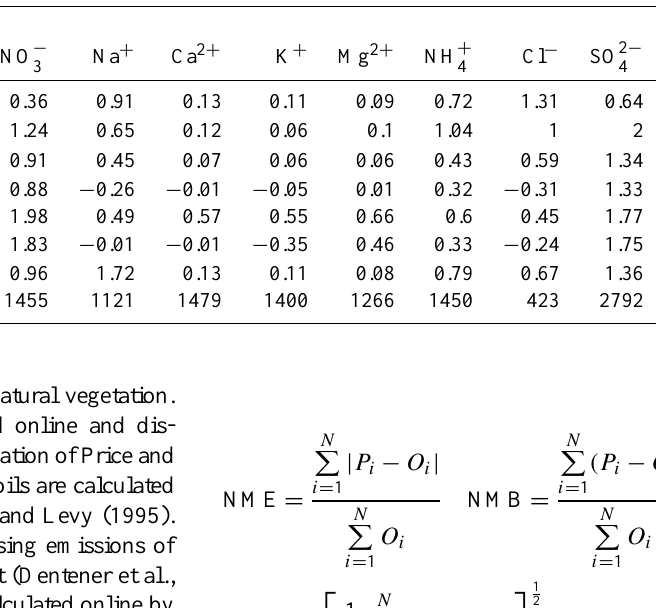
Table 2. Statistical evaluation of EMAC-simulated aerosol concentrations against monthly average observations from Europe during 2005–